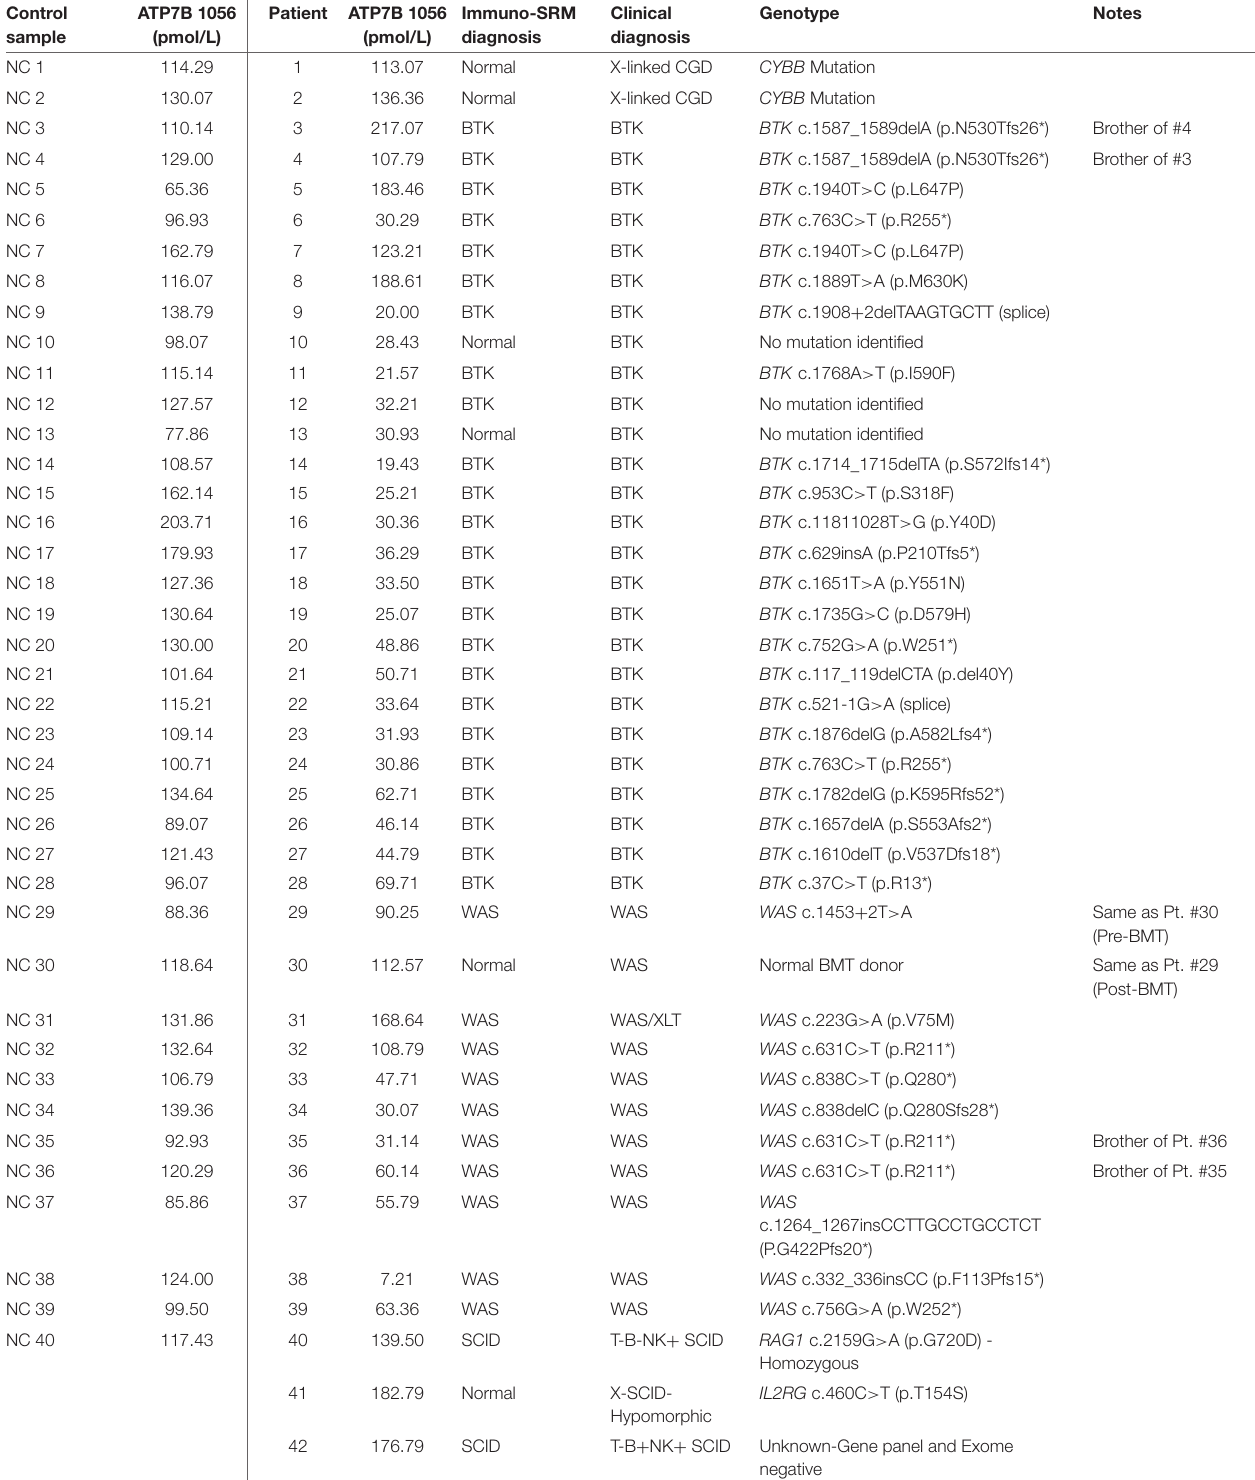
TABLE 5 | ATP7B 1056 signature peptide concentrations. Control